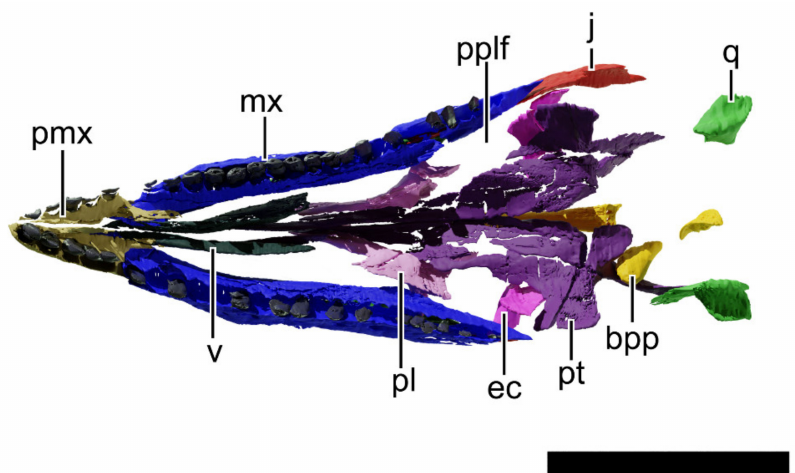
Figure 25. Digital reconstruction of the skull of NHMD 164758 in ventral view. The elements were articulated digitally for the reconstruction. Abbreviations: bpp, basipterygoid process; ec, ectopterygoid; j, jugal; mx, maxilla; pl, palatine; pmx, premaxilla; pplf, postpalatine fenestra; pt, pterygoid; q, quadrate; v, vomer. Scale bar = 50